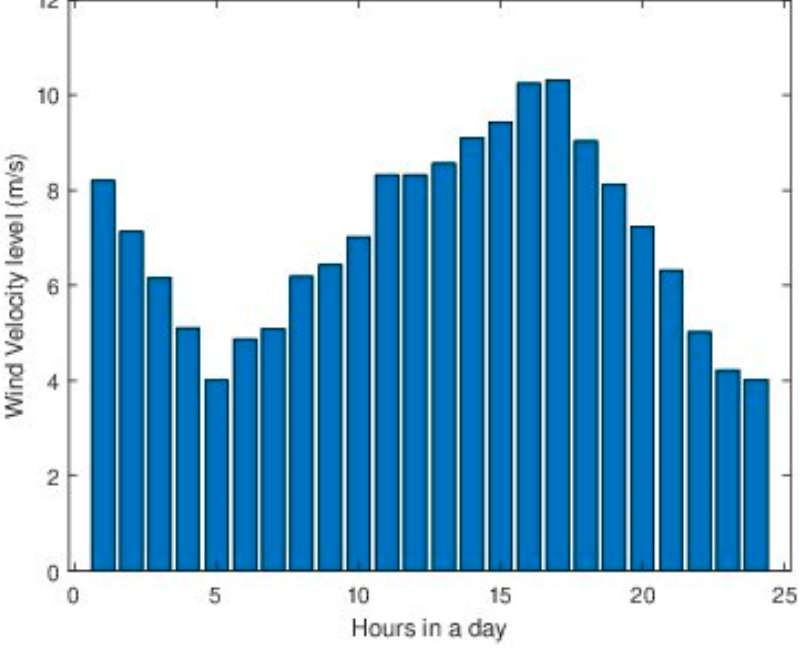
Figure 25. Predicted wind velocity profile.